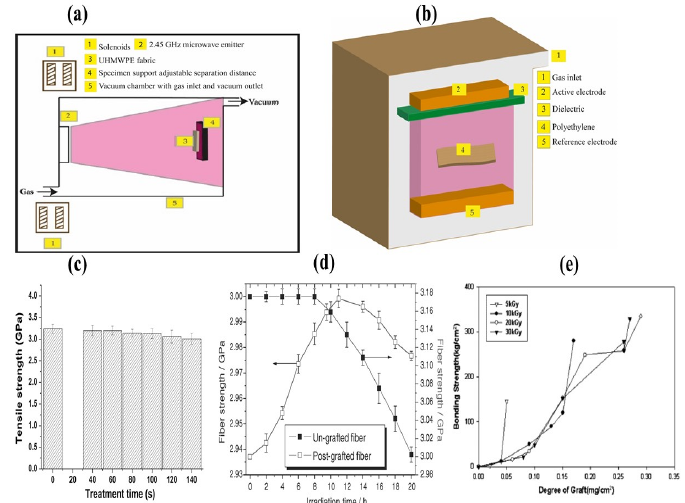
Figure 9. ( a ) Plasma treatment of UHMWPE fabric in an electron-cyclotron resonance (ECR) plasma reactor system. ( b ) Dielectric barrier discharge (DBD) plasma treatment of polyethylene fabric. ( c )